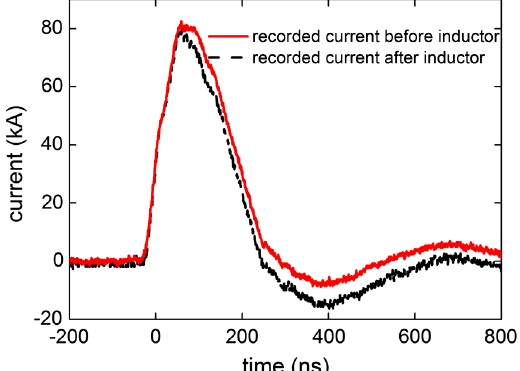
waveforms is averaged from two B-dot signals in the same cross section perpendicular to the power flow direction. The maximum currents before and after the inductor are 82.6 and 80.4 kA. The MITL voltage is about 720 kV.